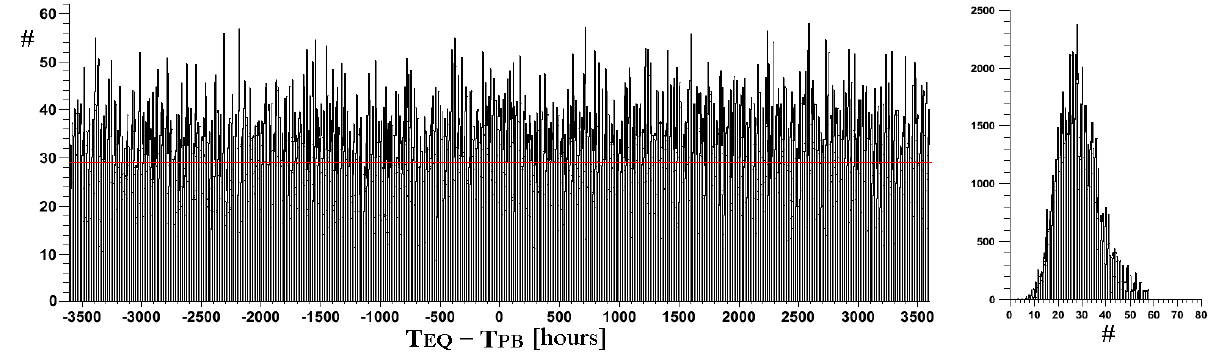
Figure 9. Correlation between M ≥ 6 EQs and continuous PBs where EQ epicenters were projection to 800 km and time differences was considered up to 150 days (left). The binning in this case was one hour. The red line is the average. The fluctuation distribution is shown on the right, it is a super-poissonian